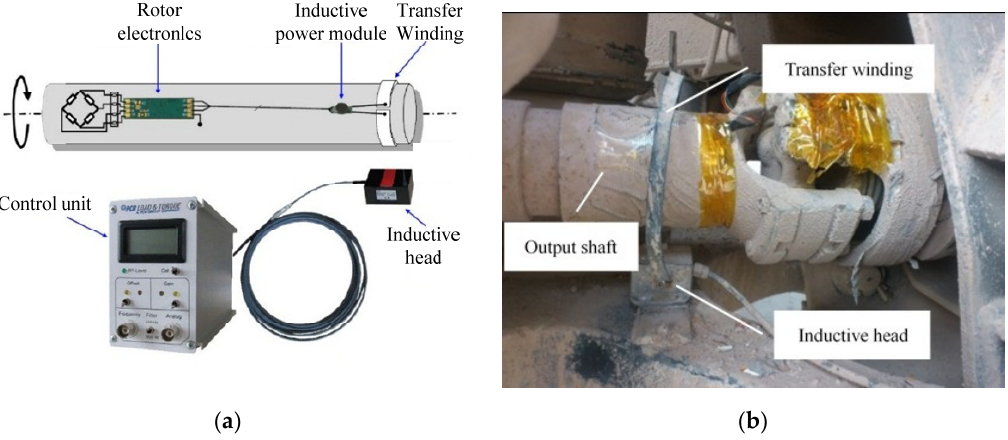
Figure 1. Rotary telemetry torque measurement system: ( a ) system configuration; ( b ) installation of the system.